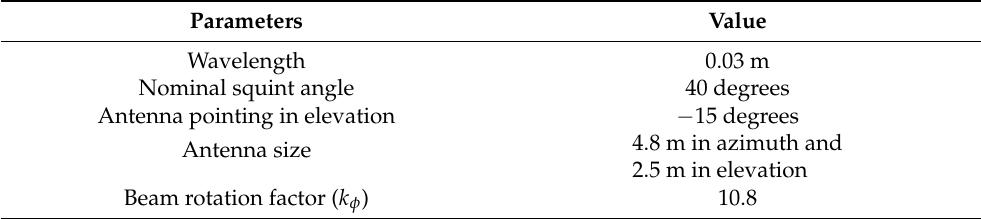
Table 1. Simulation